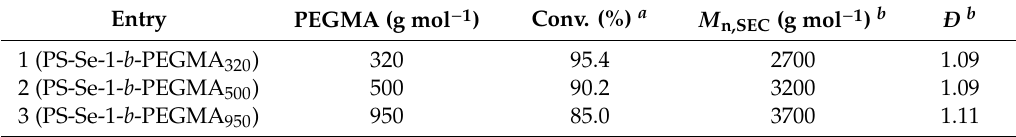
Table 3. Selenol-based nucleophilic reaction of PS-Se with di ff erent molecular weight PEGMAs.